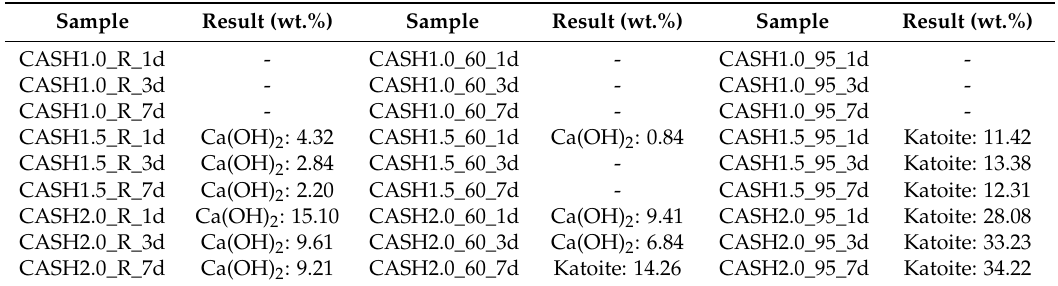
Table 2. Quantitative analysis results of C-A-S-H system using the reference intensity ratio (RIR) method. Sample Result (wt.%) Sample Result (wt.%) Sample Result